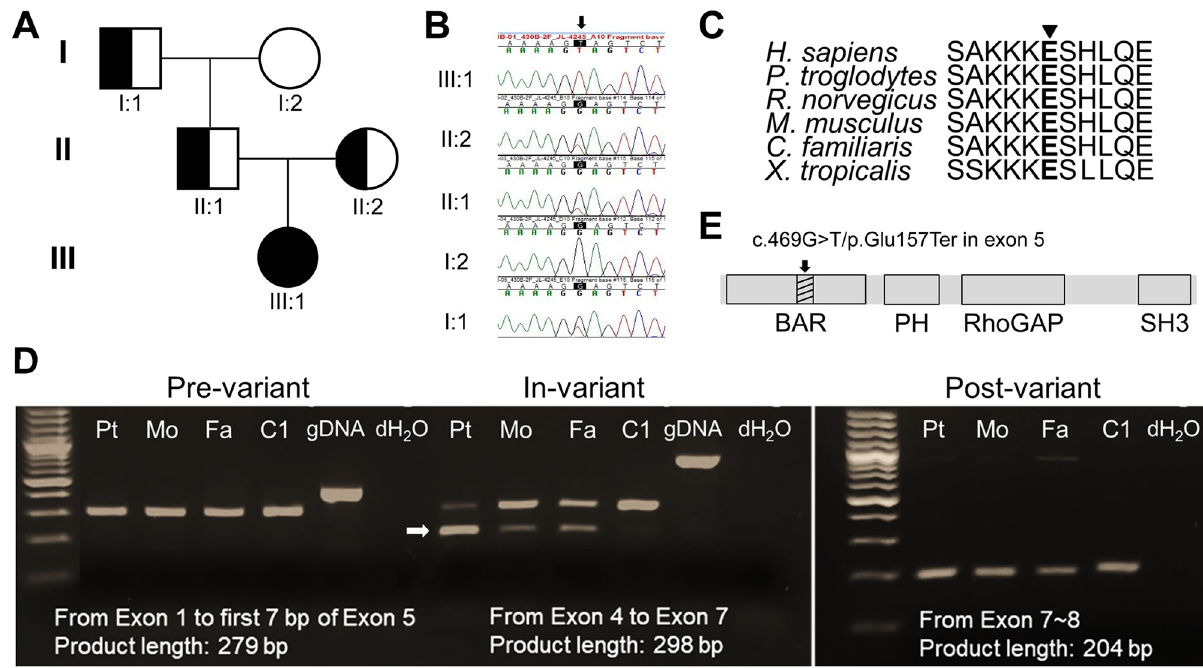
Fig 3. Genetic findings in the family with ARHGAP42 stop-gain variant. (A) Pedigree of the family carrying ARHGAP42 variant. Half-filled symbol: heterozygous; Filled symbol: homozygous; (B) Sanger sequencing chromatogram for the family of the ARHGAP42 variant; (C) Amino acid 157 (arrowhead) is evolutionally conserved in vertebrates; (D) Agarose gel electrophoresis result of ARHGAP42 pre-variant, in-variant, and post-variant amplification by PCR in cDNA samples extracted from blood. The smaller band (arrow) corresponds with exon 5 deletion confirmed by Sanger sequencing. Pt: patient; Mo: mother; Fa: father; C1: control; gDNA: genomic DNA. Pre-variant: Exon 1 to first 7 bp of Exon 5, 279 bp for ARHGAP42 cDNA. A 373 bp band seen with gDNA is from non-specific amplification of another locus; In-variant: Exon 4 to Exon 7, 298 bp for ARHGAP42 cDNA. A 618 bp band was seen with gDNA from non-specific amplification from another locus; Post-variant: Exon 7~8, 204 bp for ARHGAP42 cDNA. (E) Schematic of ARHGAP42 functional domains. The amino acid change is depicted by an arrow, and the skipped exon 5 is depicted as a shaded box in the BAR